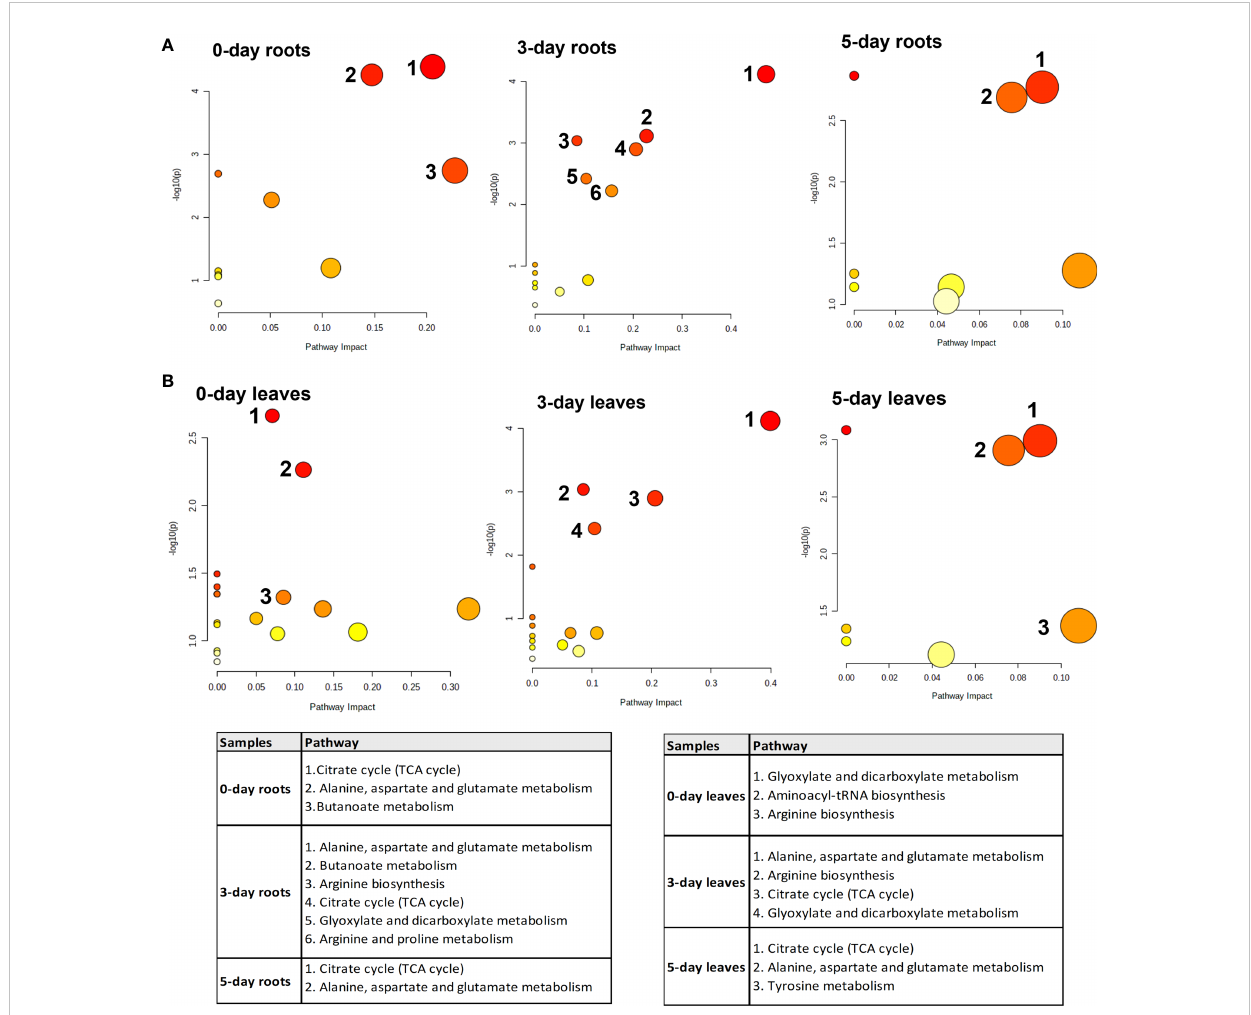
FIGURE 7 Signi fi cant enrichment pathway analysis of metabolites which showed accumulation in roots (A) and leaves (B) after the application of SWE. The y- axis (-log (p)) indicates the p-value of the pathway enrichment analysis, represented by the bubble color (darker color means more signi fi cant enrichment). The x-axis is the impact factor of topological analysis, represented by the bubble size (bigger bubble means a higher